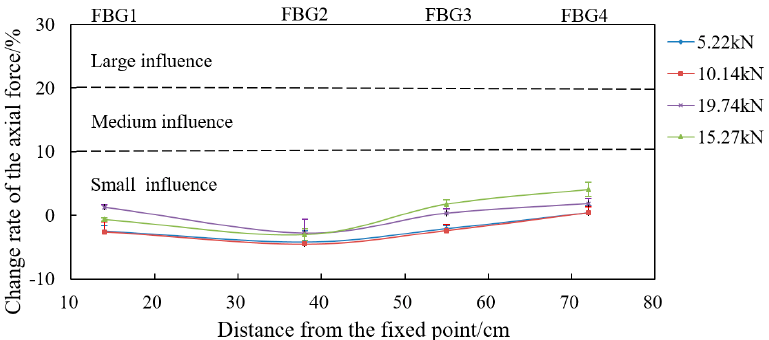
Figure 20. The variation curve of the change rate of the bolt-shaft axial force in “Active”.